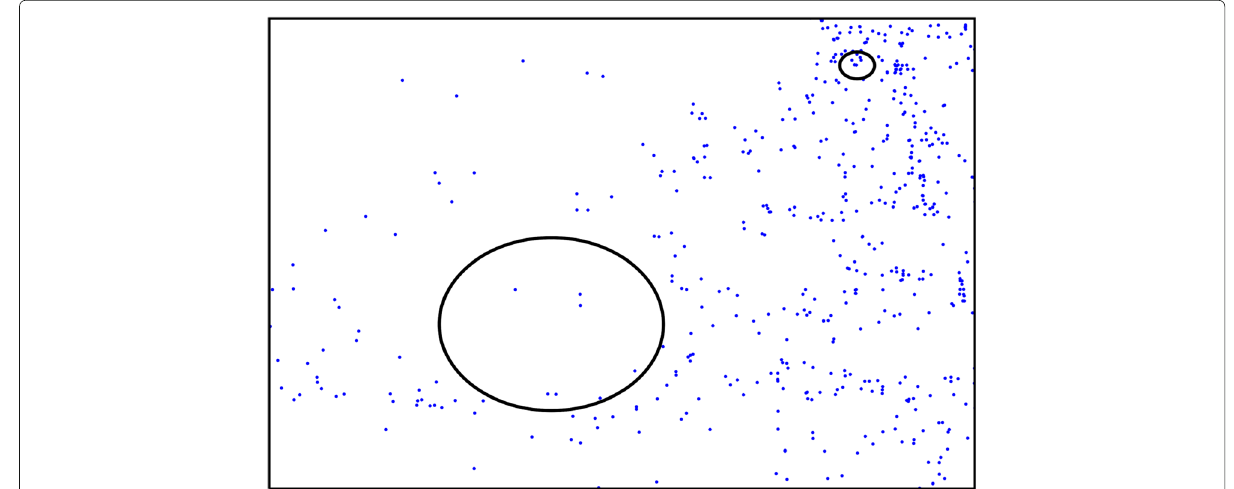
Fig. 3 Landmarks collected from